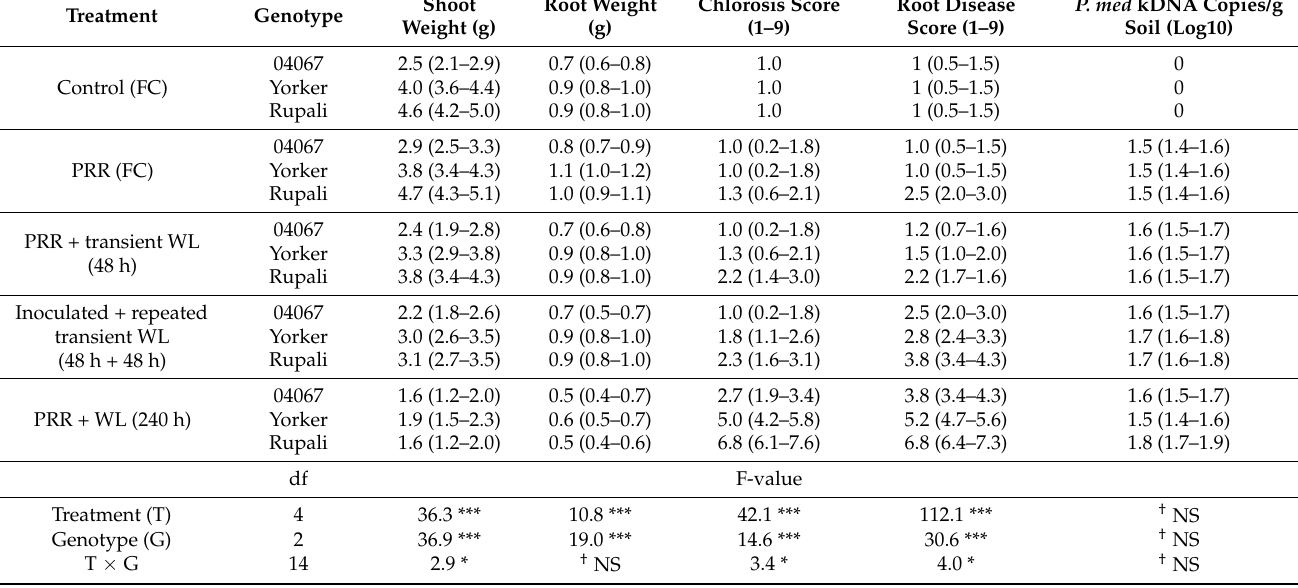
Table 3. Mean values and 5%–95% CI in parentheses for the two-way GLMM for qPCR detection of Phytophthora medicaginis (kDNA copies) growth and disease parameters for three chickpea geno- types: C. echinospermum moderately resistant BC 04067, C. aretinum moderately susceptible Yorker and very susceptible Rupali in potting media infected with P. medicaginis (PRR) under differing flooding